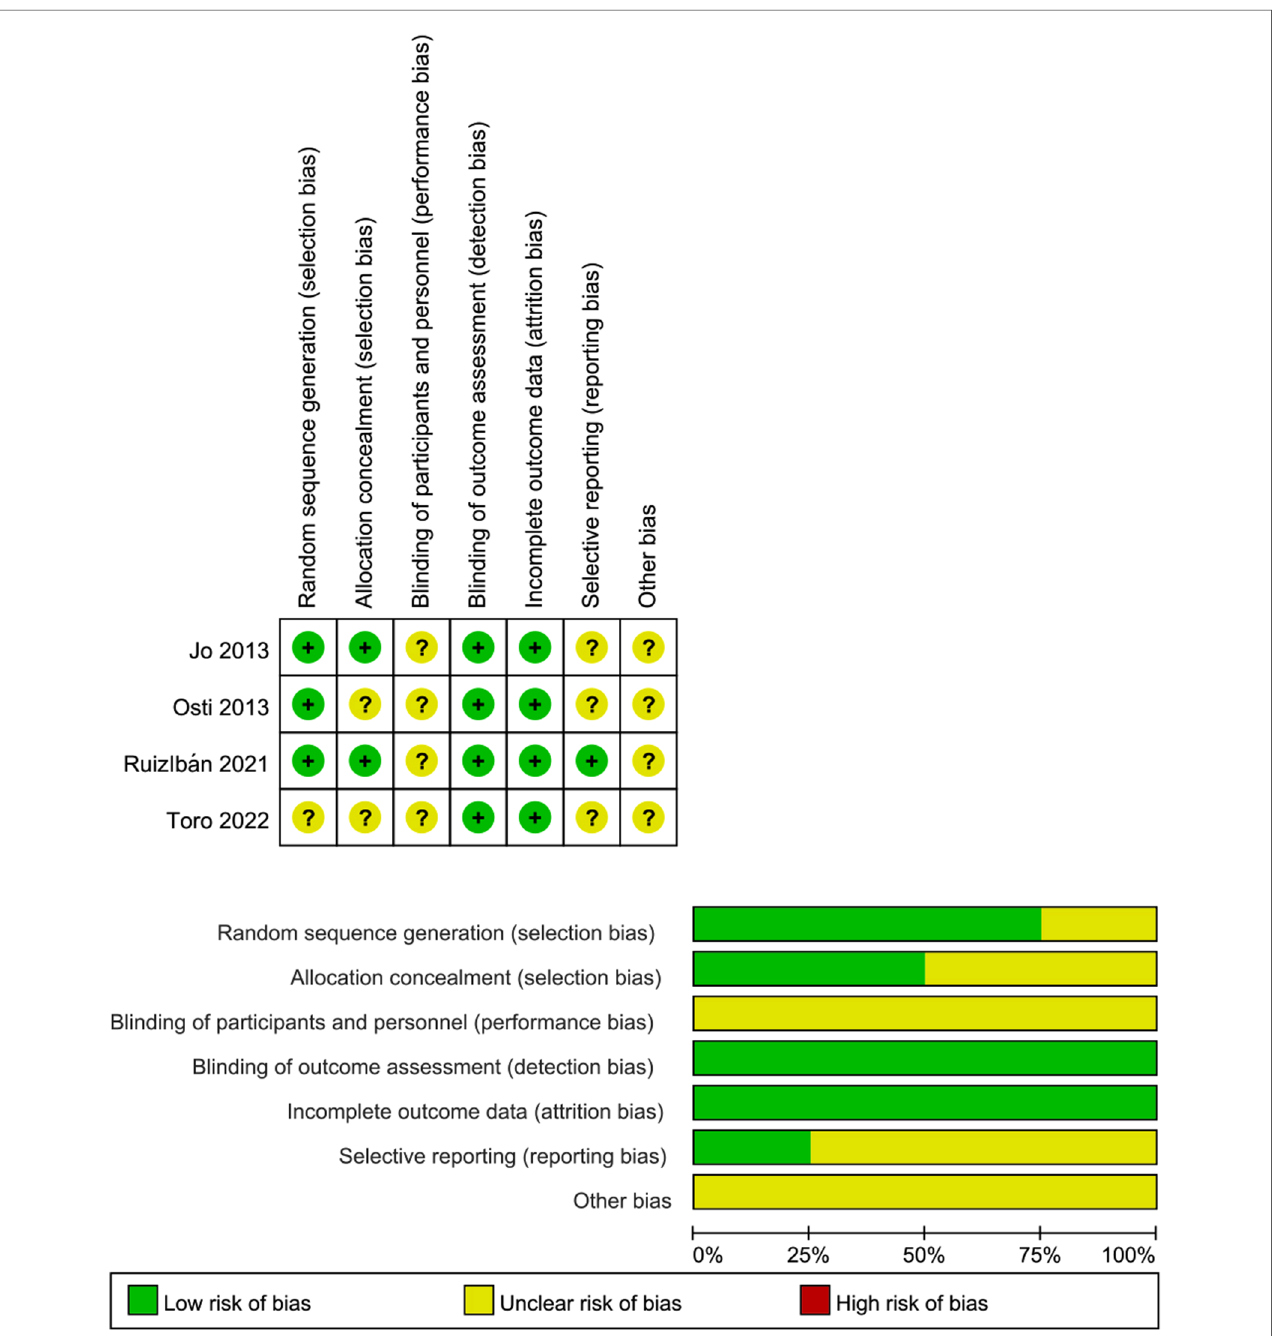
FIGURE 2 Risk of bias of included